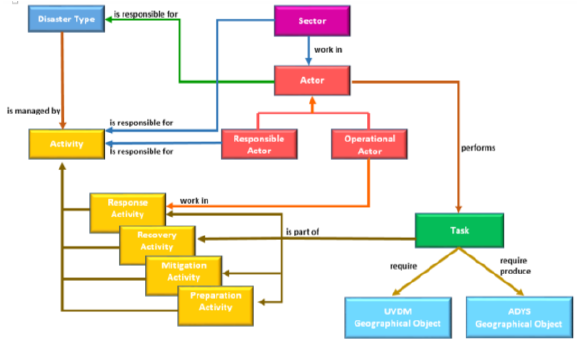
Figure 2. General conceptual approach for Disaster